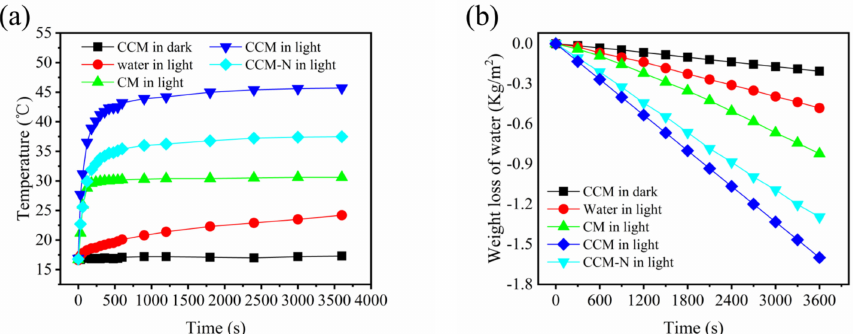
Figure 7. ( a ) Temperature changes of the water surface and membrane surface using CCM and CM under light and dark conditions; ( b ) weight loss of water using CCM and CM during the interfacial evaporation process under light and dark